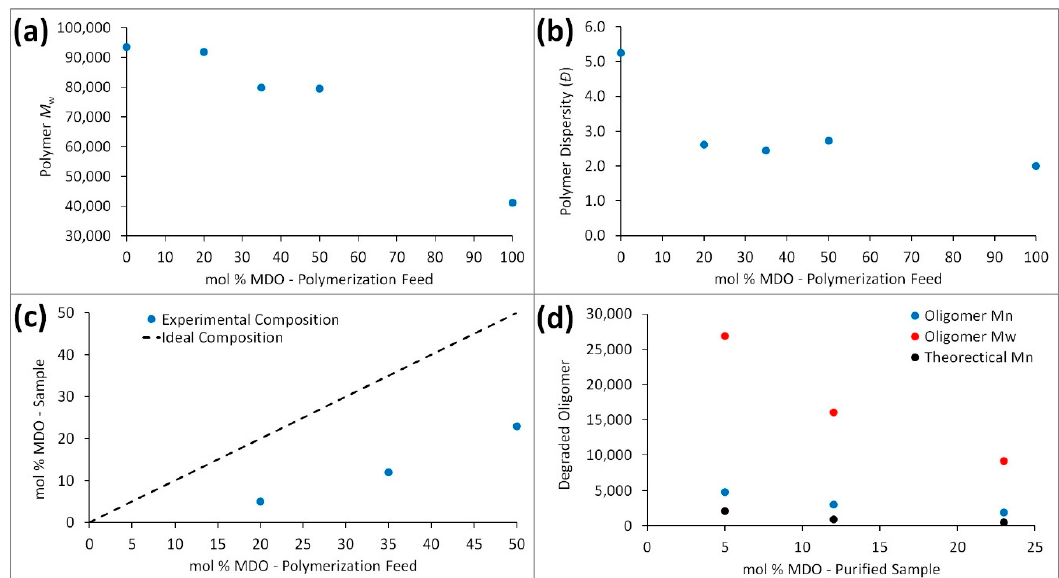
Figure 3. Polymer analysis for P1–P5 displaying mol % of MDO in polymerization feed against (a) polymer molecular weight ( M w ) and (b) polymer dispersity ( Đ ). Polymer analysis for P2–P4 displaying (c) mol % of MDO in polymerization feed against mol % MDO in a purified sample and (d) mol % MDO in purified samples against degraded oligomer molecular weight.